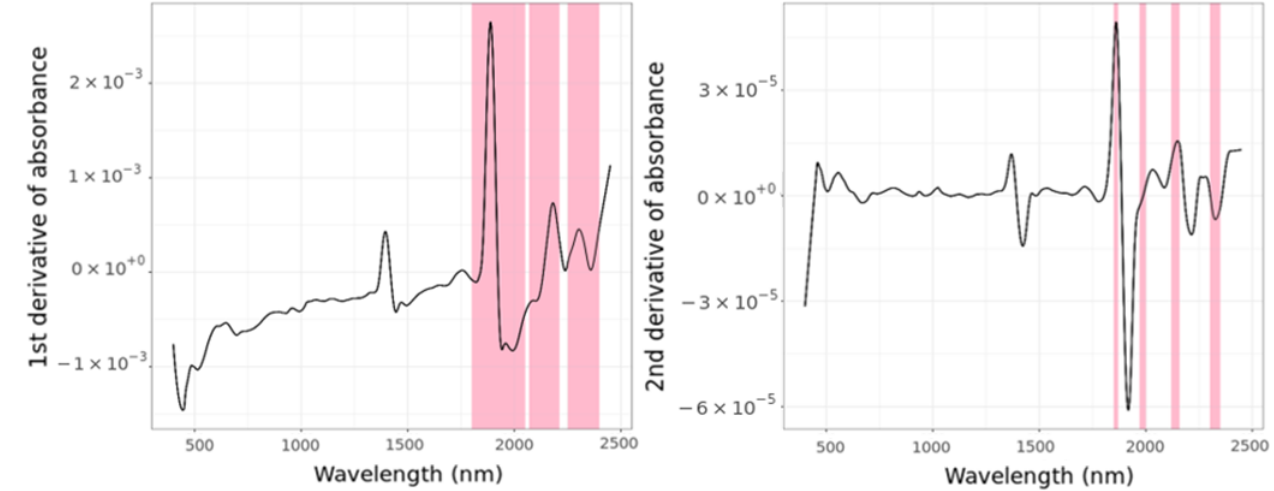
Figure 15. 1st and 2nd derivatives of the laboratory (PSR+ 3500) spectral signature with a high CaCO 3 content. The important spectral regions are highlighted in pink. The interval size varies according to the preprocessing method applied.